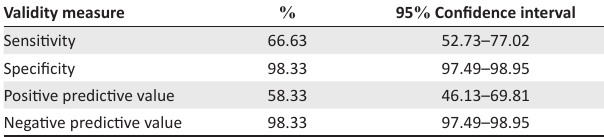
TABLE 2: Screening efficacy of teachers: validity parameters.